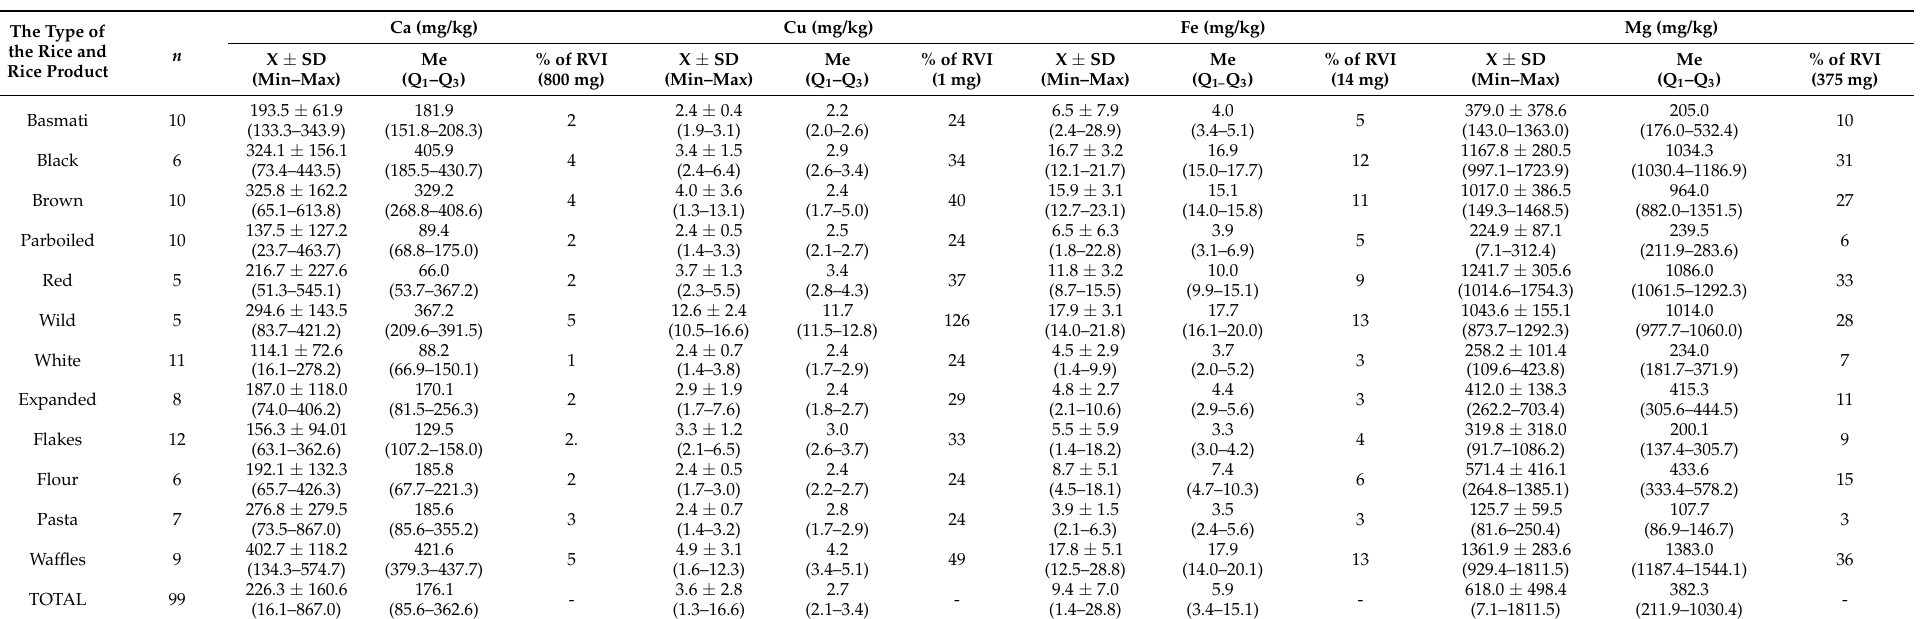
Table 3. The content of studied elements (Ca, Cu, Fe, Mg) measured in rice and rice